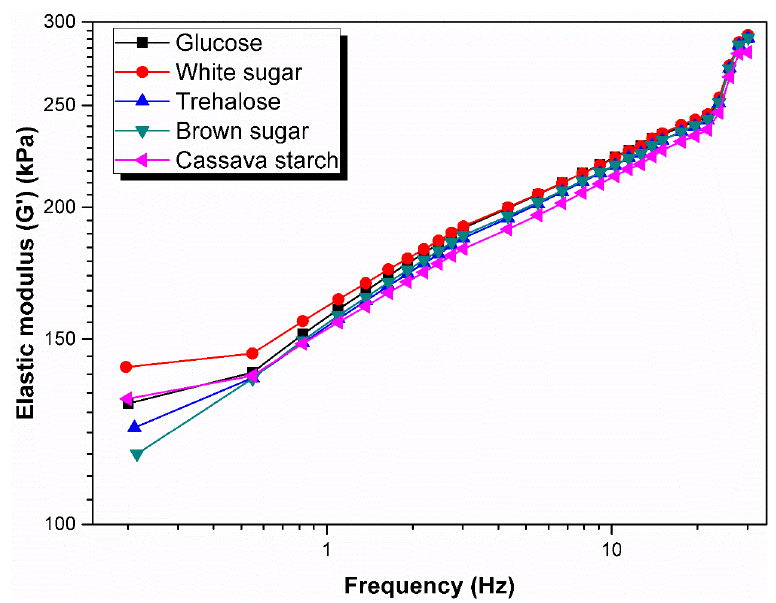
Figure 6. Elastic modulus as a function of frequency of raw natural rubber resulted from coagulation with different sugars.